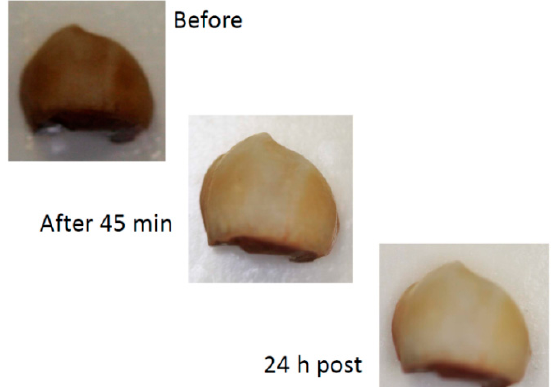
Figure 3. Example of the effect of 45 min bleaching in-office and 24 h after bleaching procedure and wet storage (digital camera).